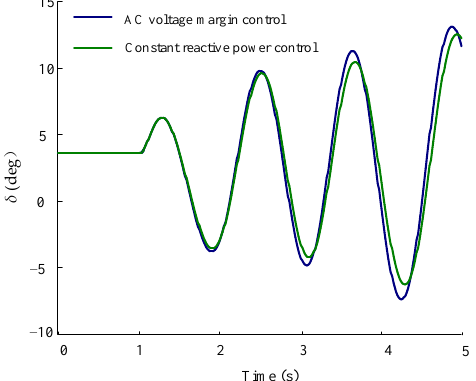
Figure 7. Generator angle oscillations under di ff erent VSC-HVDC control Figure 7 . Generator angle oscillations under different VSC-HVDC control modes.